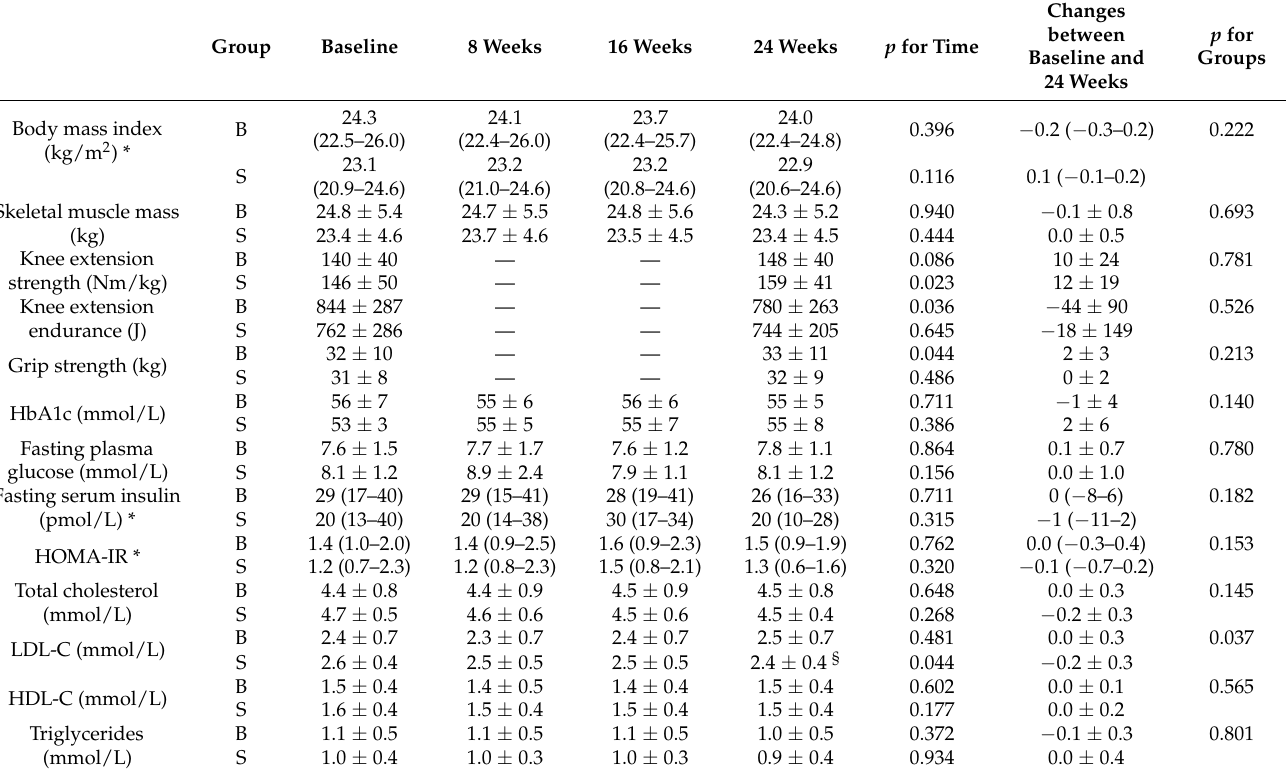
Table 3. Changes in body composition, muscle strength, and glucose and lipid parameters during the 24-week intervention